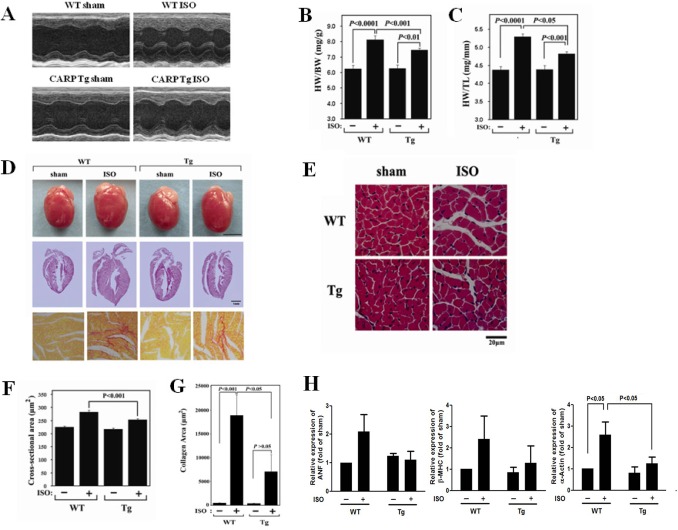
Isoproterenol-induced cardiac hypertrophy is attenuated in CARP Tg mice.WT and CARP Tg mice were continuously infused with vehicle (100 µmol/L ascorbic acid) or isoproterenol at a rate of 30 mg/kg/day using a subcutaneously implanted mini-osmotic pump. After 14 days, mice were sacrificed for assessment of cardiac hypertrophy. (A) Representative examples of M-mode echocardiograms of hearts from WT and CARP Tg mice infused with isoproterenol (ISO) or vehicle (sham). (B) The ratio of heart weight to body weight (HW/BW). (C) The ratio of heart weight to tibia length (HW/TL). (D) Staining of hearts from WT and CARP Tg mice infused with ISO or vehicle. Upper panel: Gross heart morphology; middle panel: H&E-stained longitudinal sections; lower panel: PSR-stained sections. (E) H&E staining of sections from the left ventricular myocardia of WT and CARP Tg mice infused with ISO or vehicle. Scale bar  = 20 µm. (F) Quantification of cross-sectional areas in the cardiomyocytes shown in (E). (G) Quantification of collagen areas in the myocytes shown in (D). (H) Changes in the expression levels of mRNAs transcribed from the ANF, β-MHC, and α-actin genes after infusion of isoproterenol in WT and CARP Tg mice. mRNA expression levels were quantitated using real-time PCR.